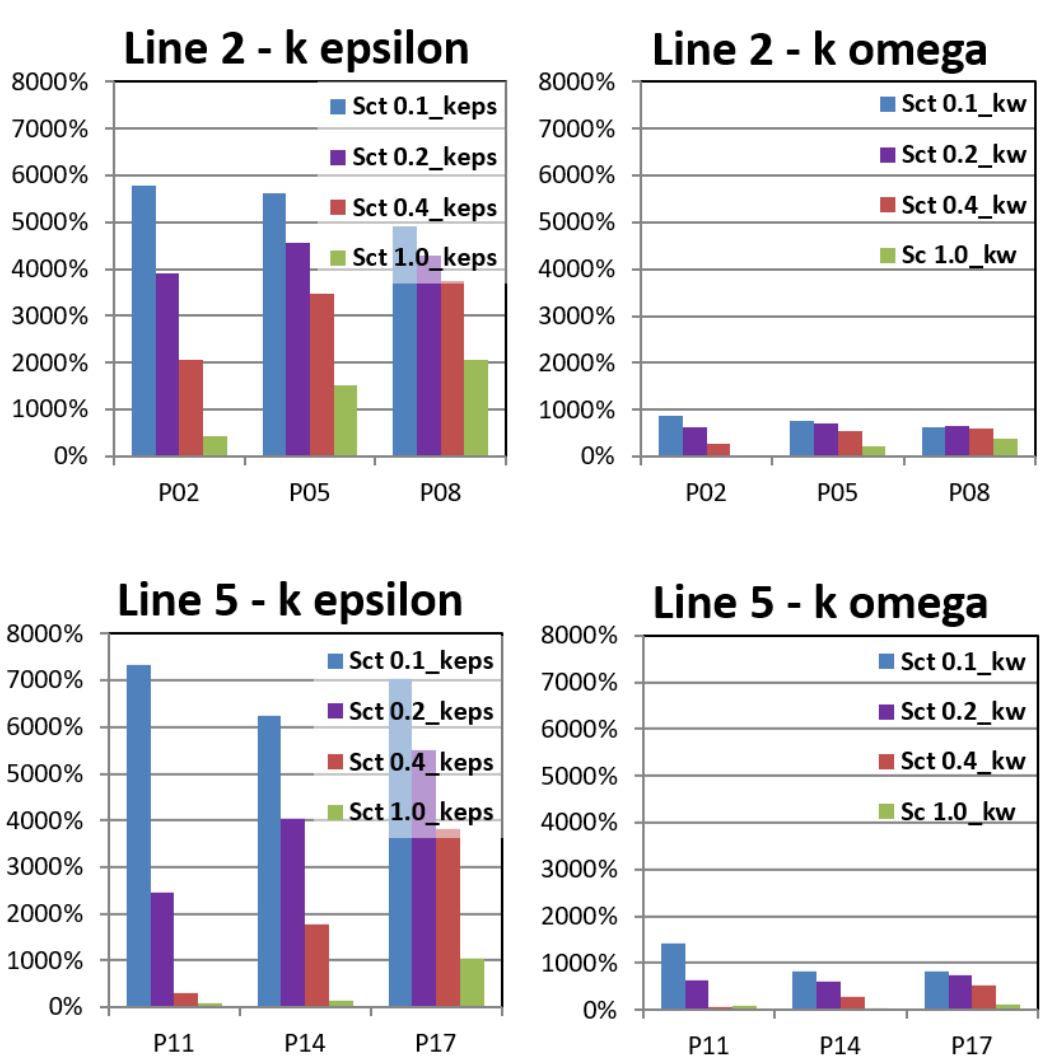
Figure 8. The influence of the turbulent Schmidt number on the simulated absolute concentration of gas relative to the measured concentration; evaluation at the points of Lines 2 and 5; left, the result of the k-epsilon model, and right, the result of the k-omega